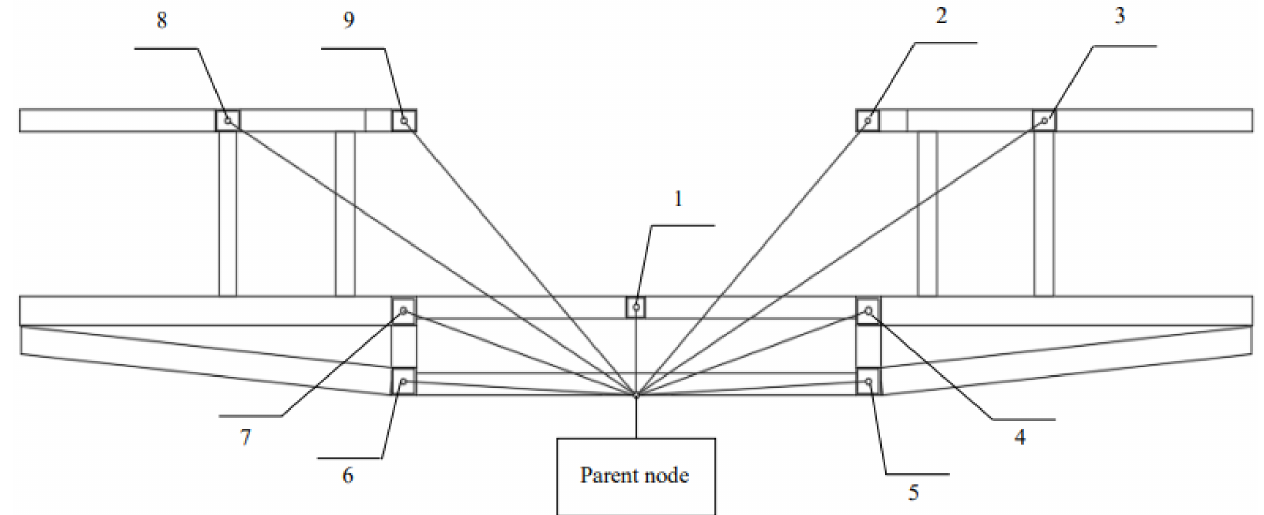
Figure 9. Schematic diagram of the front interface node network of the middle frame module; the node numbers are referred in Table 1. Table 1. Information for the front interface of the middle frame module